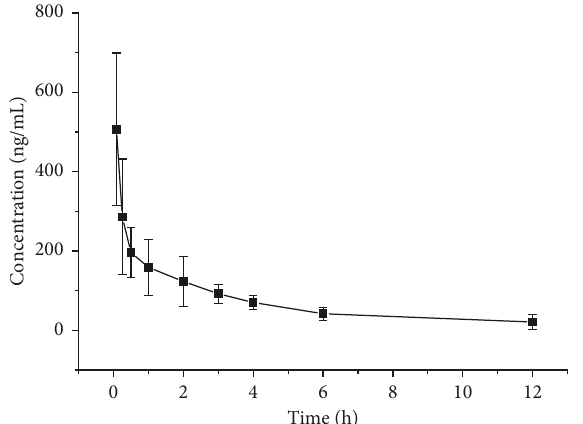
Figure 3: The mean plasma concentration-time profile after in- travenous administration of jervine (1.5mg/kg).